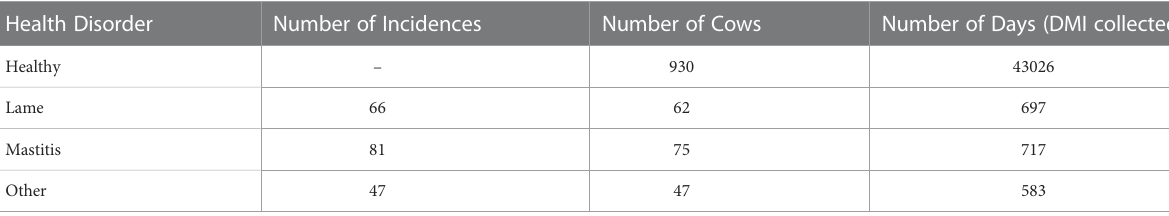
TABLE 1 Summary of health disorders in the full